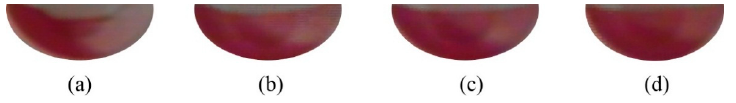
Figure 6. Images of the liquids after ( a ) one mixing cycle, ( b ) two mixing cycles, ( c ) three mixing cycles, and ( d ) four mixing cycles, respectively.